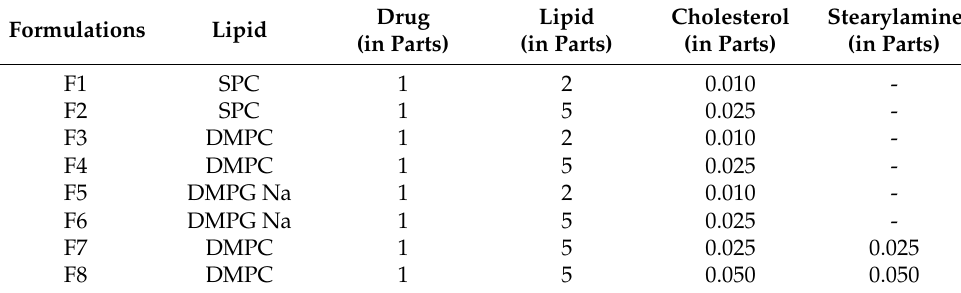
Table 6. Formulation composition of proliposomes.